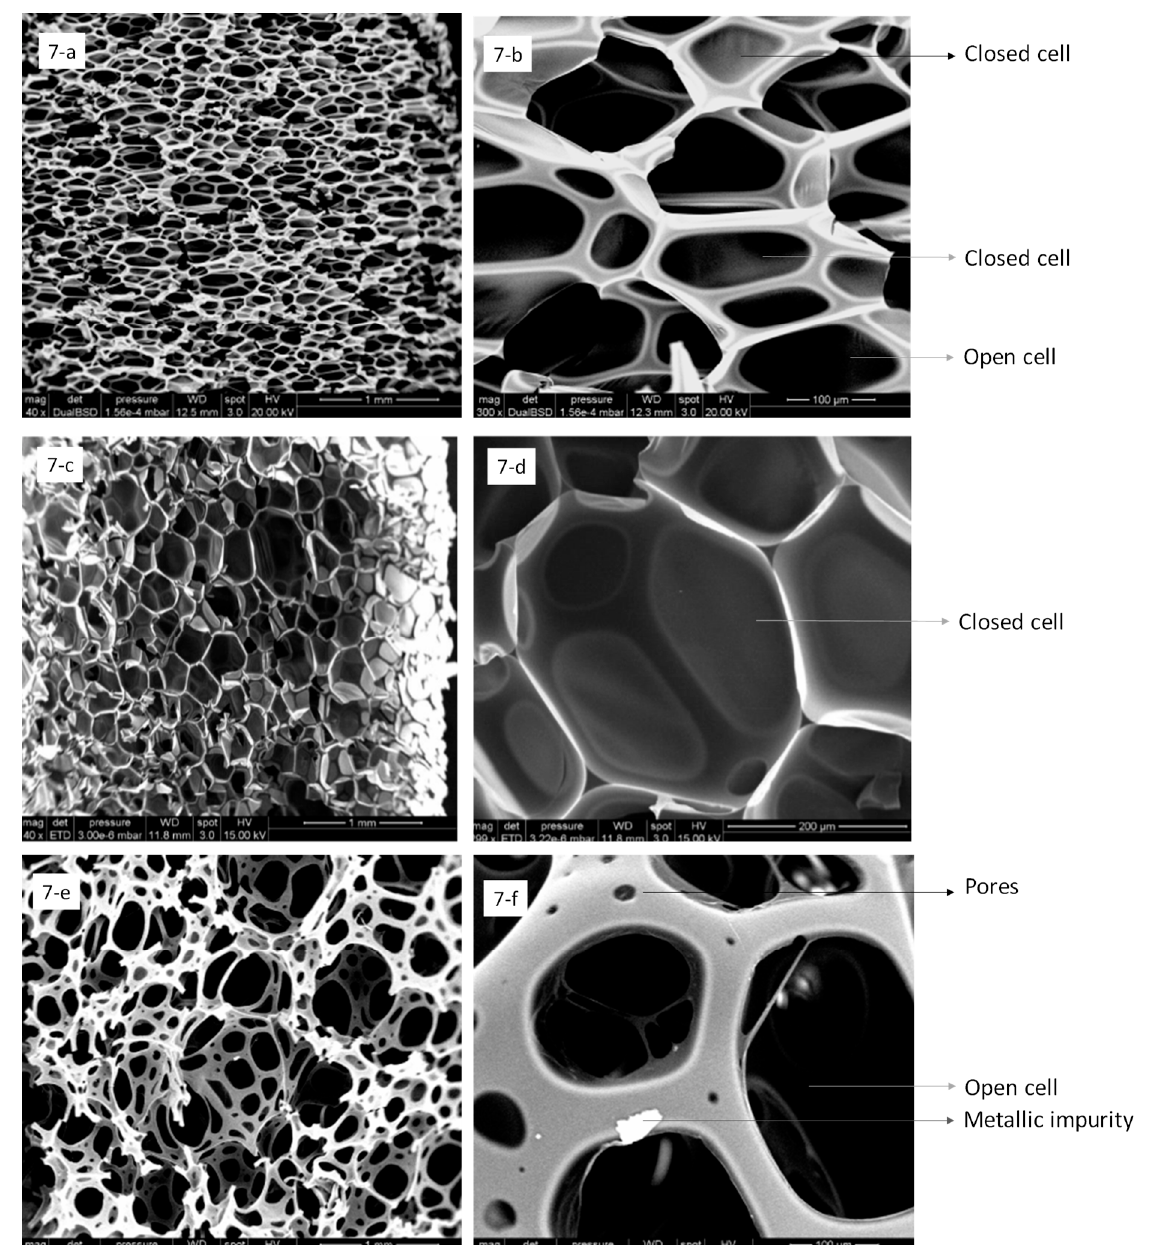
Figure 7. ( a , b ) Microestructure of the PU waste (B); ( c , d ) PU waste (I) and ( e , f ) PU waste (A) by SEM.